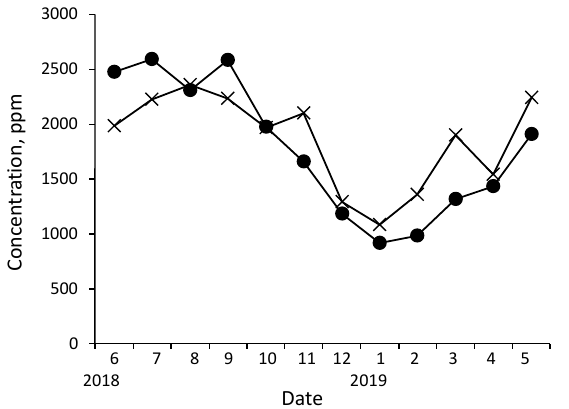
Figure 5. Seasonal variation in the concentrations of K in the xylem sap obtained in Experiment 3. The data represent the mean values of three conspecific trees. ●: Q. serrata , ×: C. japonica .